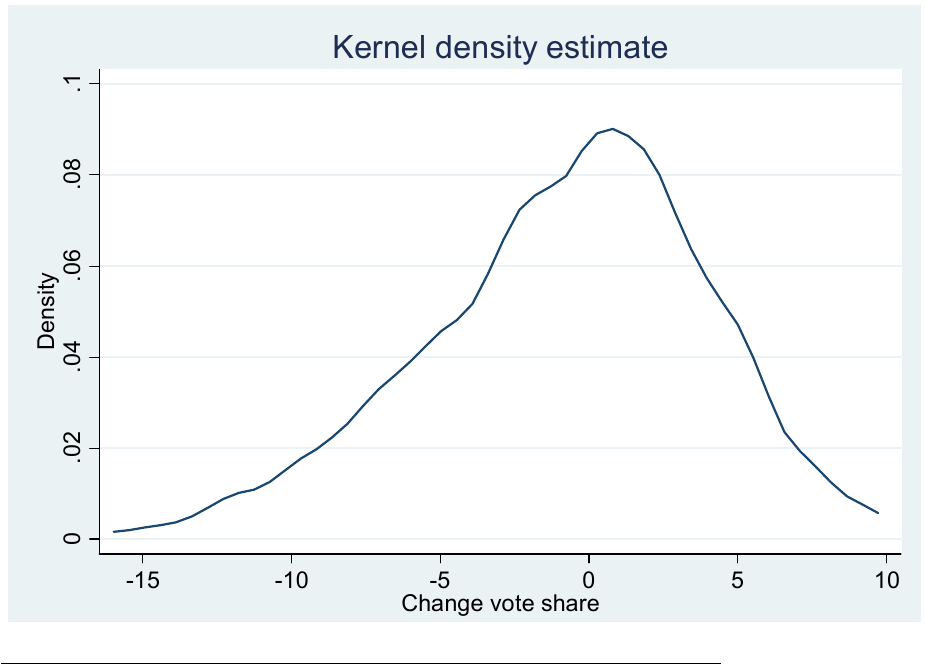
Figure 1: Kernel density plot of vote change of incumbent parties (per